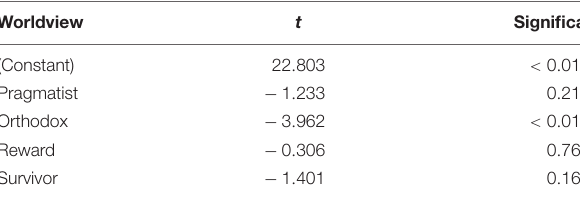
TABLE 8 | Predictors for recreational cannabis improves quality of